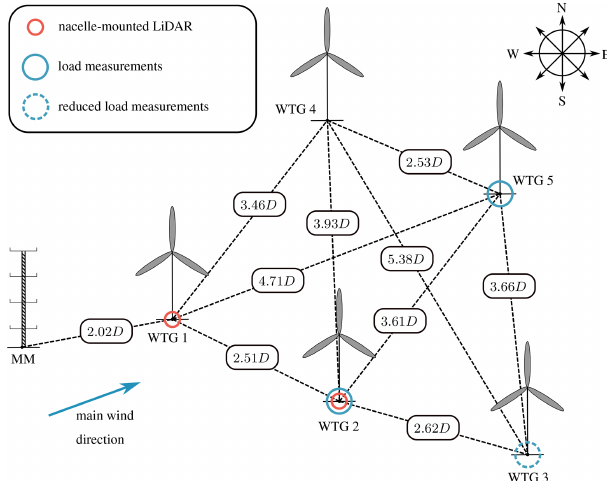
Figure 1. Wind farm layout with measurement equipment (Rein- wardt et al.,